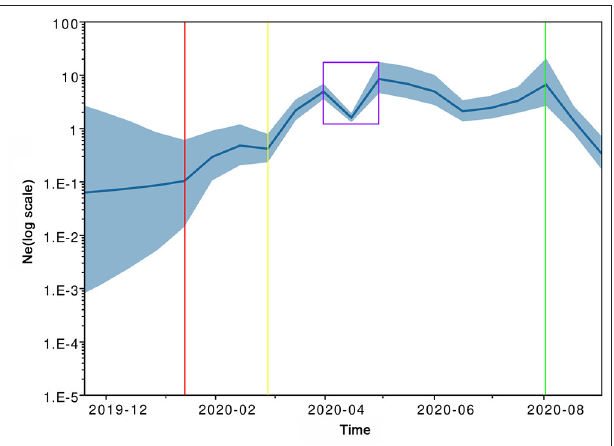
FIGURE 4 | Historical changes in effective population size (Ne) of severe acute respiratory syndrome coronavirus 2 (SARS-CoV-2) circulating in Southeast Asia by September 2020. The blue line represents posterior point estimates; the blue band represents 95% Bayesian credible interval (BCI). The red, yellow, and green vertical lines mark the watersheds corresponding to two accelerated expansions and one significant contraction; the purple box marks a temporary setback followed by a rapid